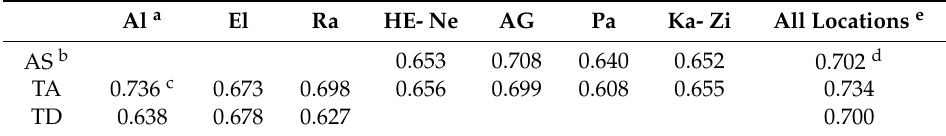
Table 3. Variation within separate populations and species ( α -diversity) for incidence data based on FECs of individual plants.